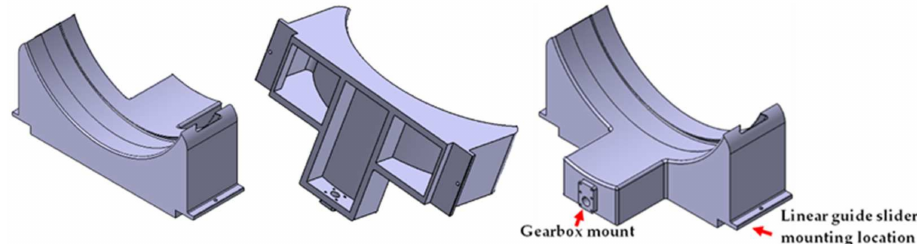
Figure 8. Support structure for the modified gantry.